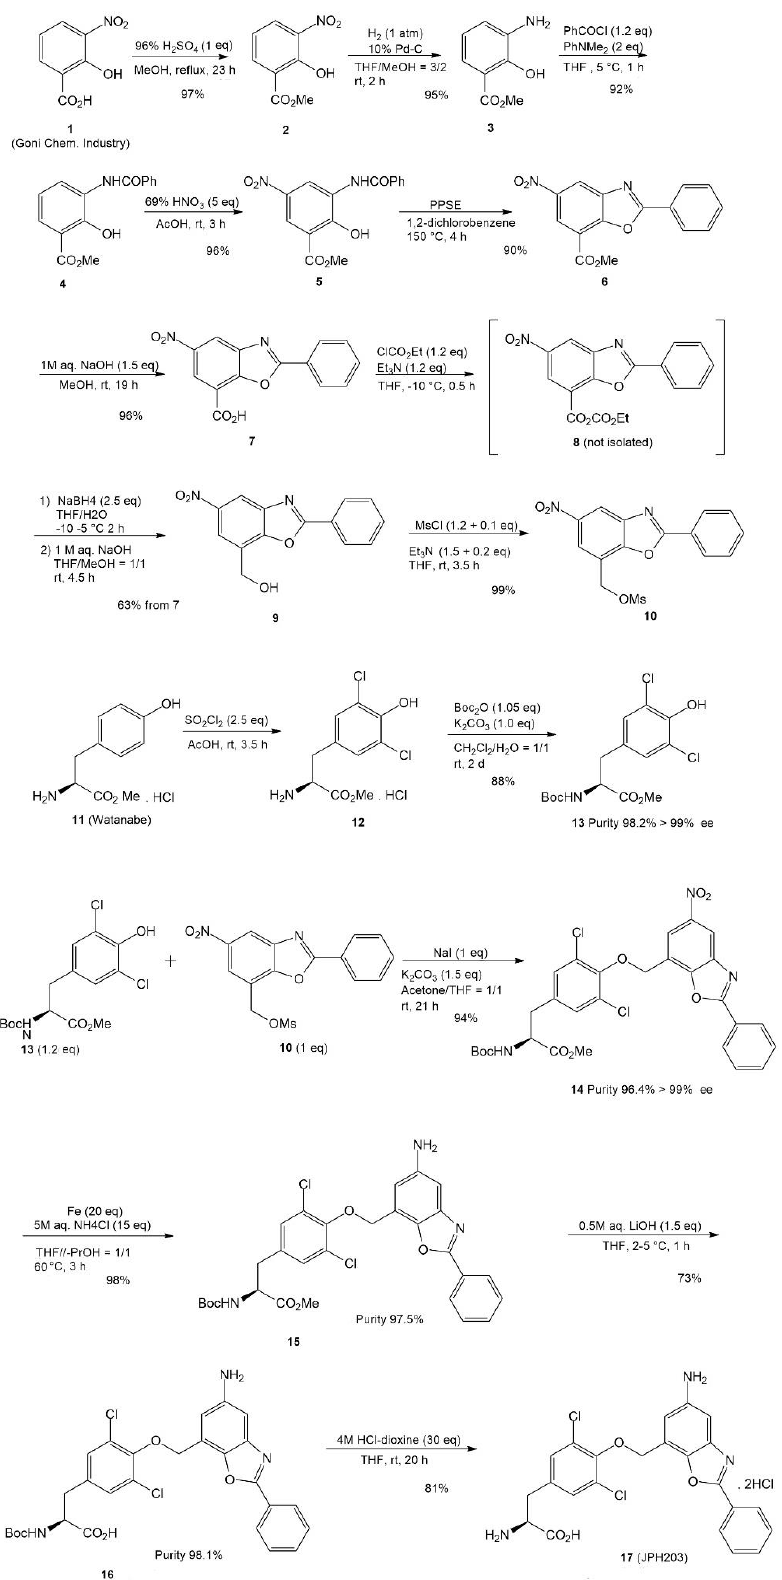
Figure 3. JPH203 synthesis pathway shows protection in aminopropanoic groups [42].